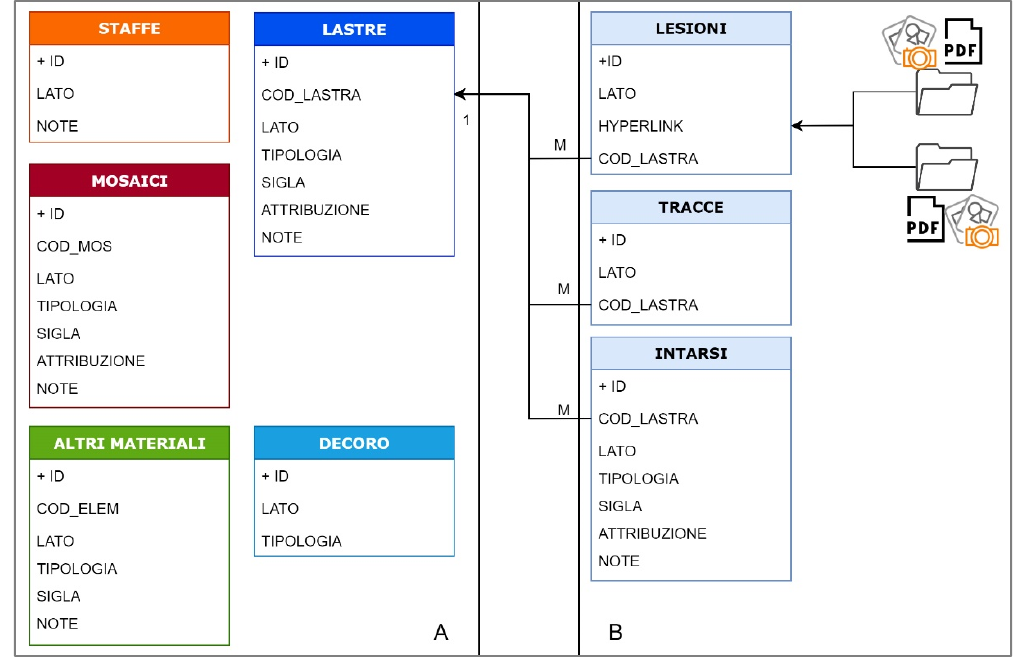
Figure 5 . Information System Schema referred to Battistero. ( A ) Polygon layers; ( B ) layers referred to base element “lastre”, relation one to many.